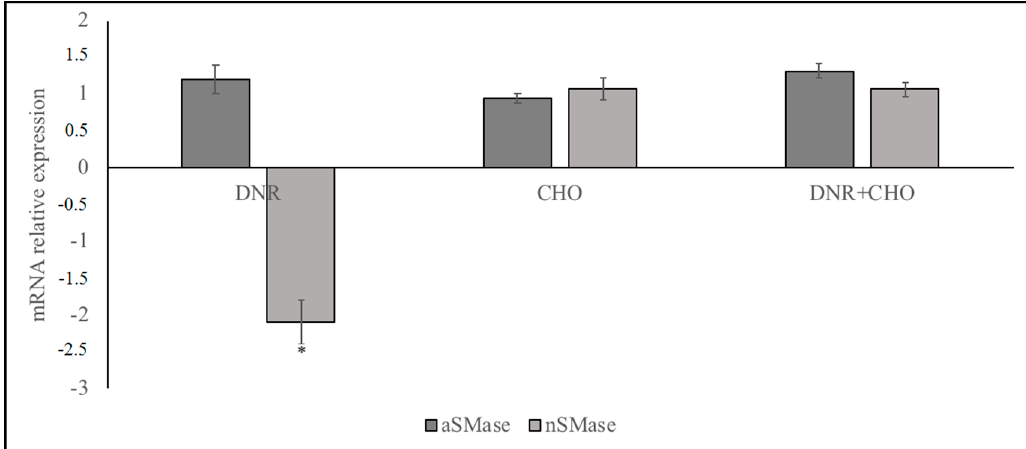
Figure 2. Effect of DNR, CHO, DNR–CHO on aSMase and nSMase gene expression. Cells were treated with 1 μ M DNR or 800 nM CHO or 1 μ M DNR + 800 nM CHO. RTqPCR analysis was performed on control (CTR) and treated cells, by using GAPDH as a housekeeping gene. On the ordinate, mRNA relative expression = mRNA of treated cells/mRNA of control cells. Data are expressed as the mean ± SD of three independent experiments performed in three PCR replicates. ∗ p < 0.05.